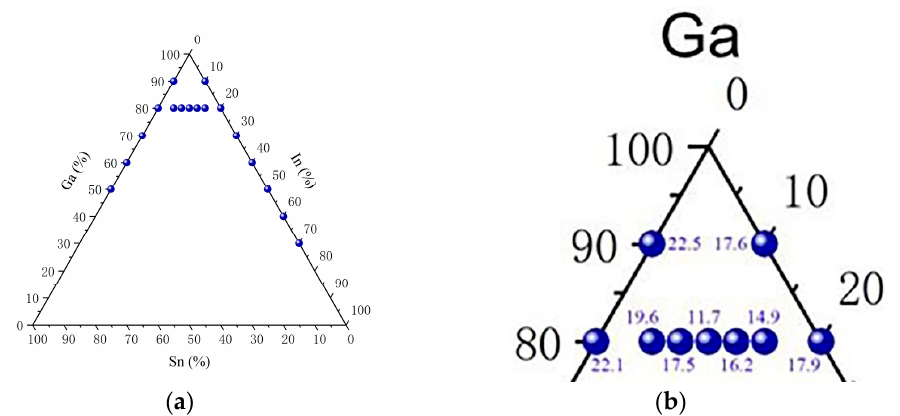
Figure 5. ( a ) Melting point diagram of Ga-In-Sn alloy; ( b ) Enlarged fi gure.